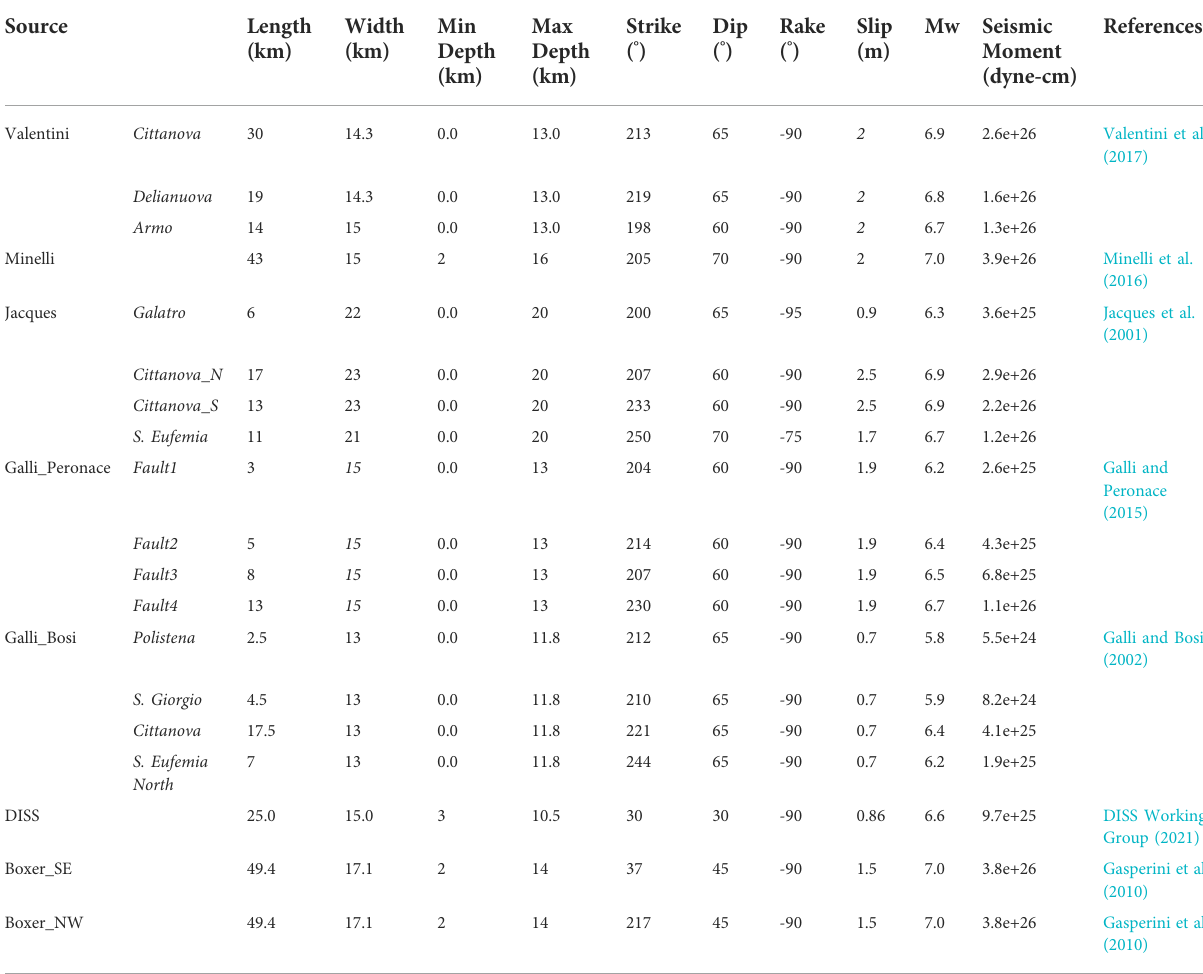
TABLE 1 List of the 8 potential sources of the 1783 earthquake that represent the input to the modelling of the coseismic static strain. The names of the single fault segments belonging to a fault system are indicated in italic. The fault parameters not explicitly indicated by the authors are inferred from the empirical relationships by Hanks and Kanamori (1979), Wells & Coppersmith (1994), or from geometric relationships and are indicated in italic. The moment magnitude Mw has been recalculated from the seismic moment associated with each segment.